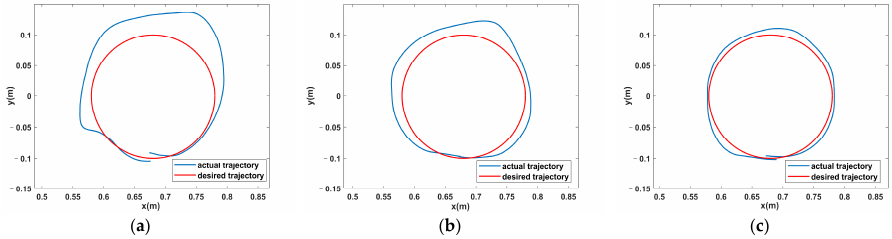
Figure 13. S1’s task trajectory diagram in FAP mode: ( a ) task1, ( b ) task7, and ( c ) task19.